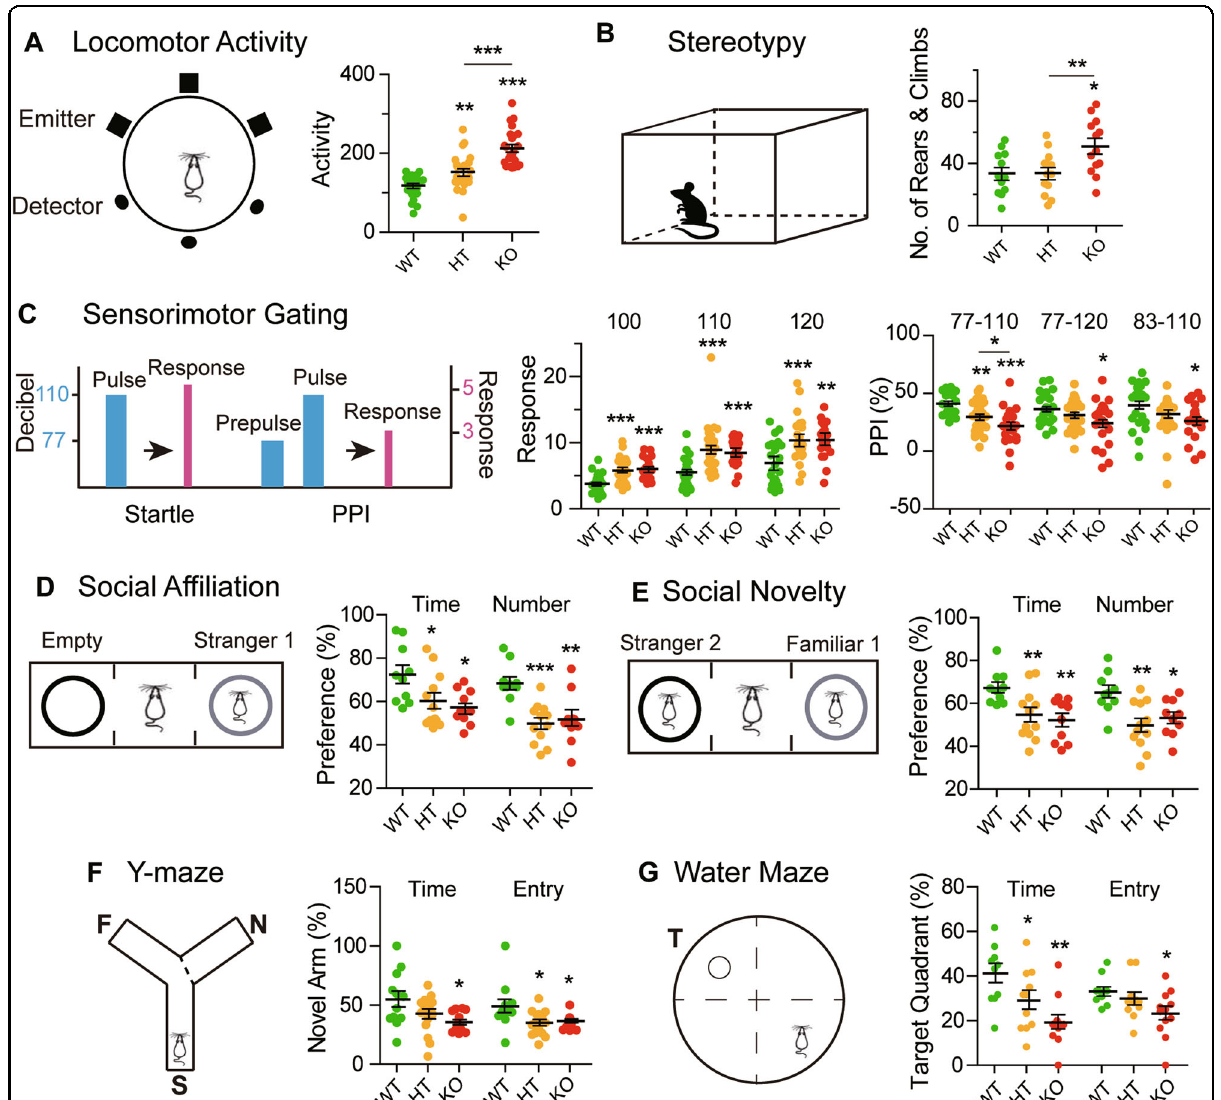
Fig. 2 Schizophrenia-like behavior. a Locomotor activity: movement of mice across emitter beams during a 5-min interval (WT male n = 22, HT male n = 23, KO male n = 23). b Behavioral stereotypy: numbers of rears and climbs during a 5-min interval (WT male n = 12, HT male n = 13, KO male n = 13). c Sensorimotor gating based on PPI: acoustic startle response was shown for the 100, 110 and 120 dB pulse-alone trials; and PPI = 100% × [(Pulse-alone trial − Prepulse-pulse trial)/Pulse-alone trial] in the 77 – 110, 77 – 120, and 83 – 110 dB prepulse-pulse trials (WT male n = 21, HT male n = 25, KO male n = 21). Three-chamber social behavior tests for assessment of d social af fi liation: preference for container holding